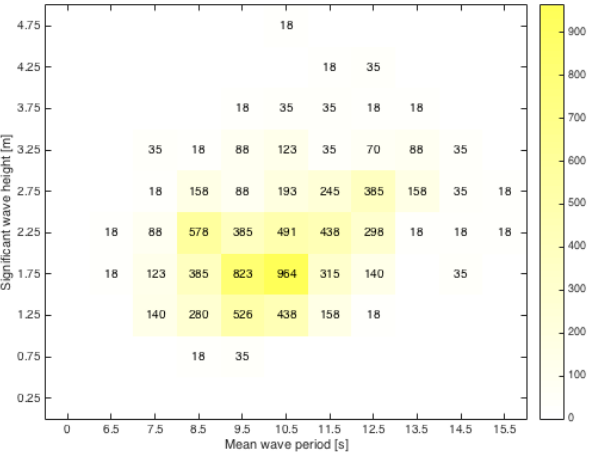
Figure 8. Scatter diagram of sea states on the west coast of Chile (centre of area is at 21 ◦ 30 (cid:48) S, 71 ◦ 30 (cid:48) W). Numbers indicates occurrence in hours per year.